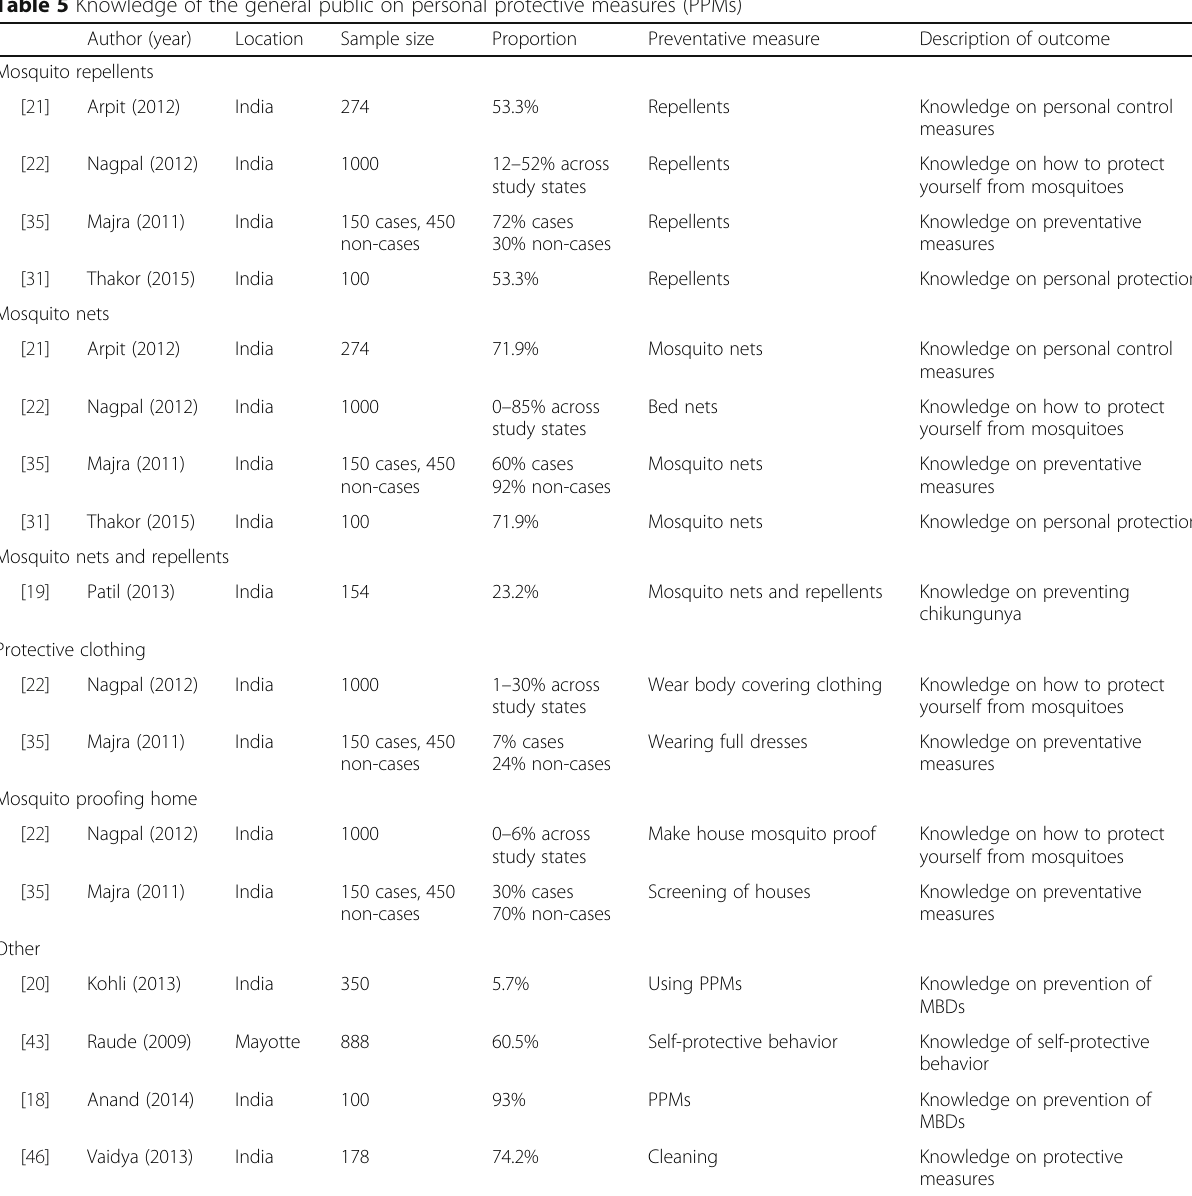
Table 5 Knowledge of the general public on personal protective measures (PPMs) Author